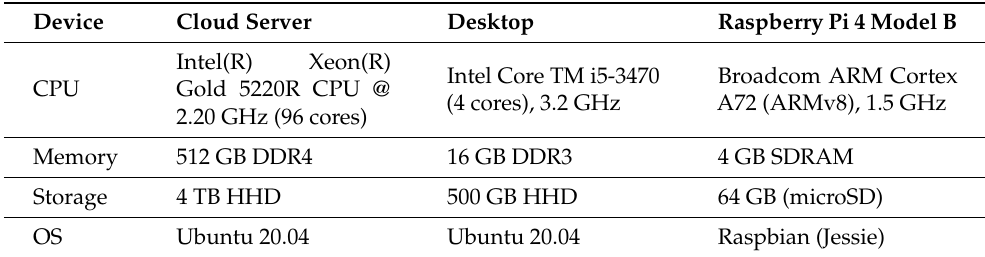
Figure 3. The experimental setup and network configuration. Table 1. Configuration of experimental